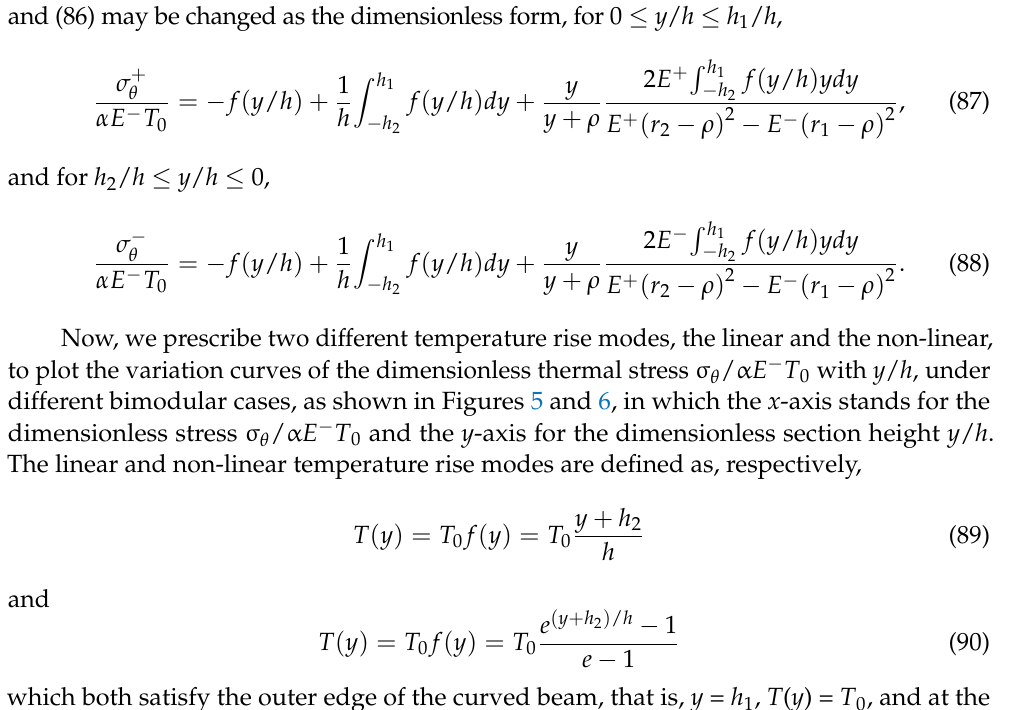
Figure 6. Thermal stress variation along thickness direction under non-linear temperature rise.